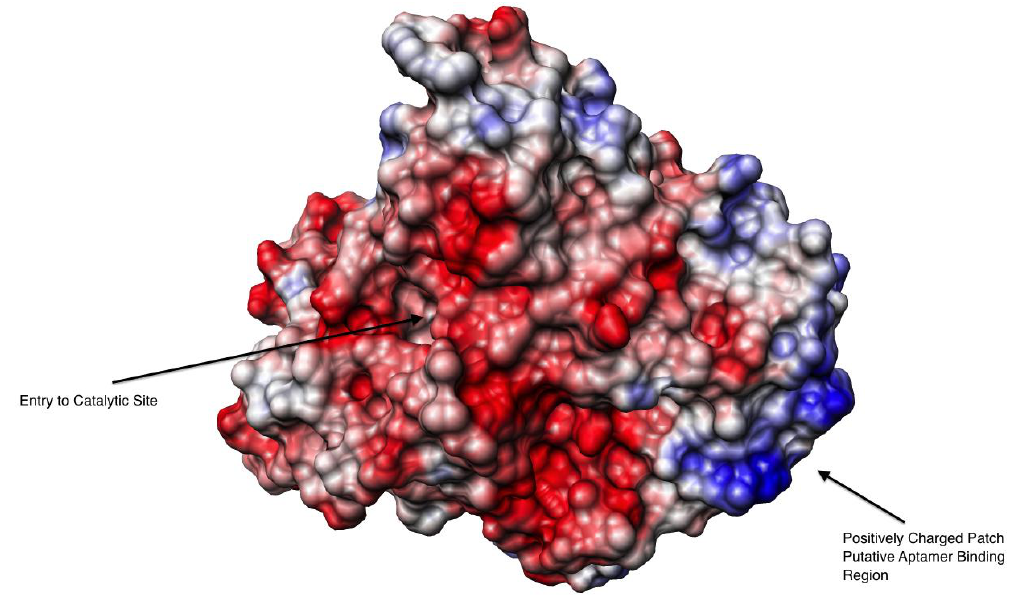
Figure 3. Columbic surface of an electric eel AChE tetramer created using Chimera software. The red color presents negative charge whilst the blue is for positive charge. The original structural data obtained from the X-ray diffraction with a resolution of 4.5 Å